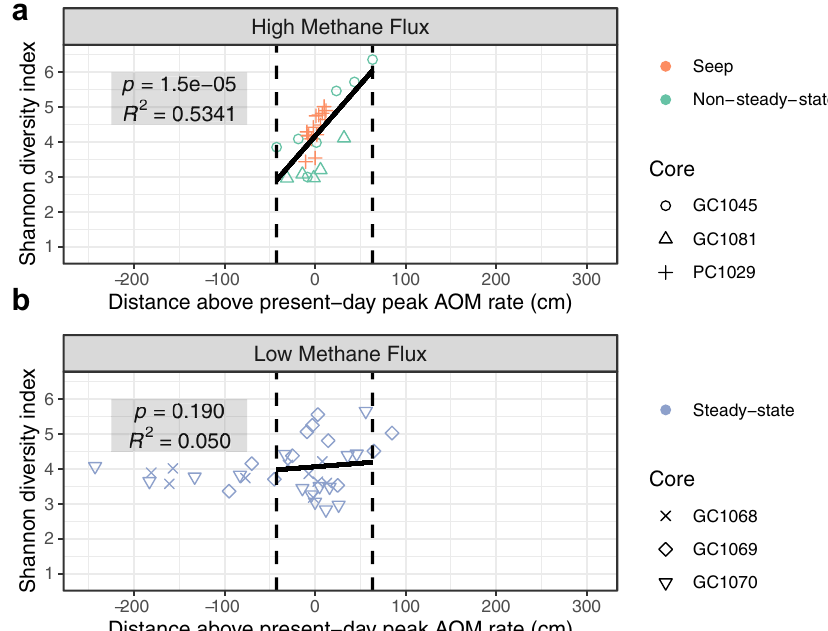
Fig. 6 Microbial community diversity patterns across depths above or below peak modeled rates of AOM. Shannon diversity indices of microbial communities for individual samples plotted by their distance above (positive) or below (negative) the depths corresponding to present-day maximum AOM rates across all cores. Cores are divided by panel based on whether methane fl ux is a high, or b low, and colored according to different states of methane dynamics. Dashed vertical lines show the distance interval corresponding to high methane fl ux samples. Multiple R 2 and slope p -values are shown for linear regressions of points within these intervals. For PC1029, we assigned 13 cm as the depth corresponding to the peak AOM rate based on the steepest decrease in porewater sulfate concentration.